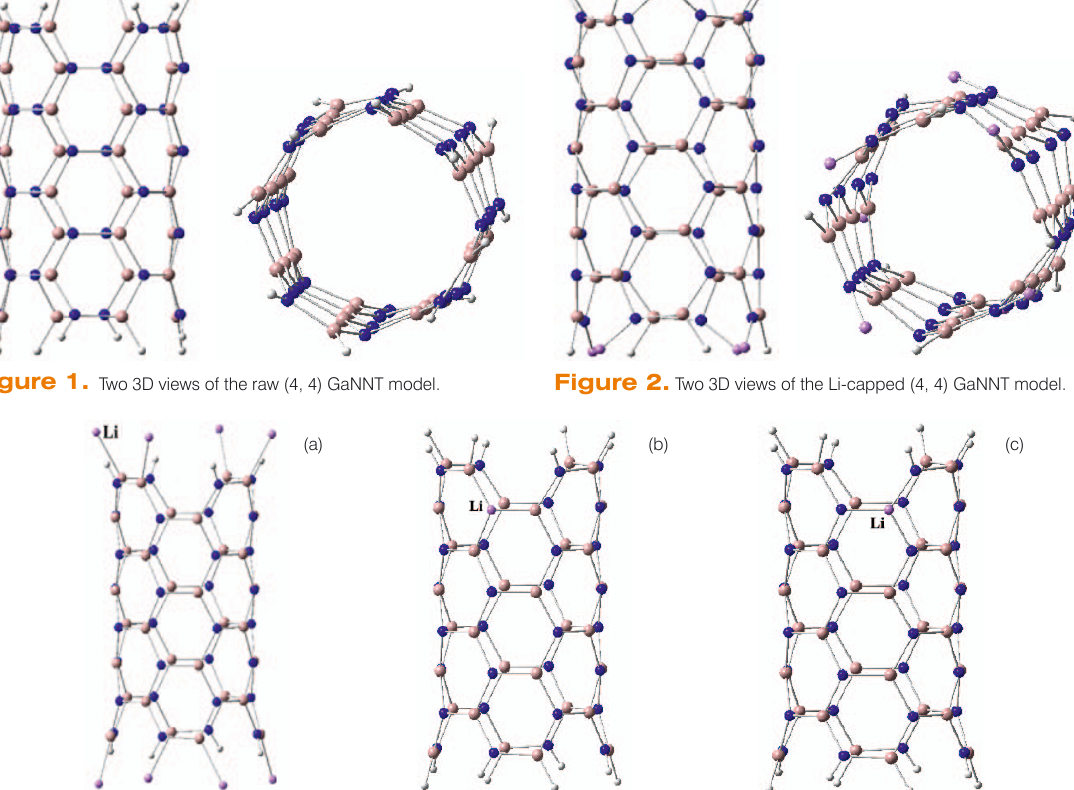
Figure 3. (a) the 3D views of Li-capped (model 3), (b) the 3D views of Li-capped (model 4) and (c) the 3D views of Li-capped GaNNTs (model 5) before